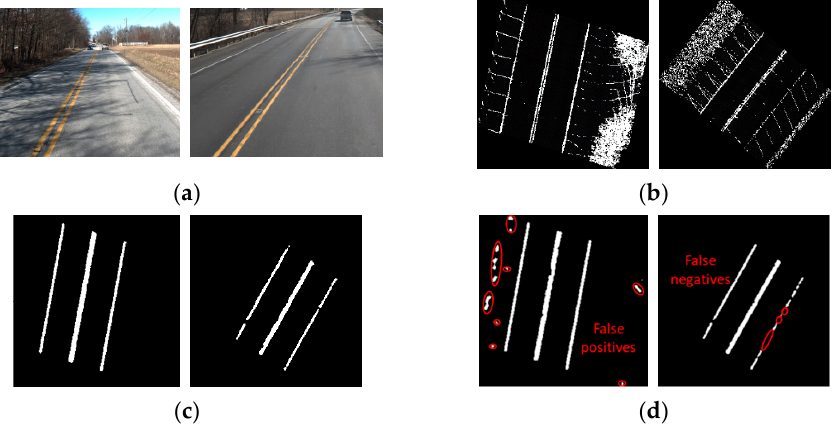
Figure 20. Better performance of encoder trained model over decoder-trained one in new test da- taset: ( a ) RGB images in different dataset segments; ( b ) corresponding input intensity images; ( c ) ( c ) encoder-trained U-net predictions; ( d ) decoder-trained U-net predictions showing false positives